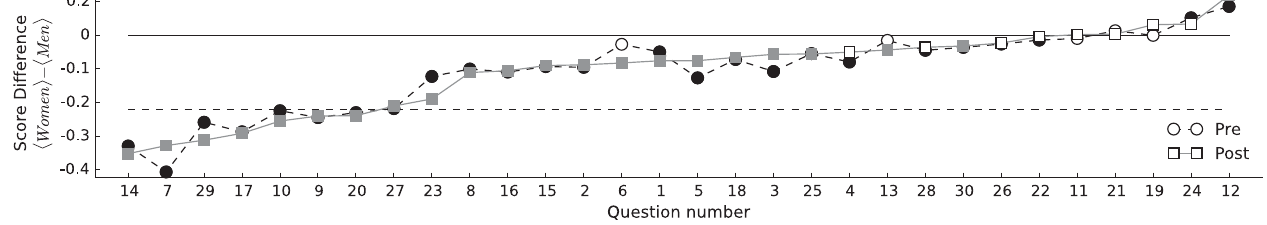
FIG. 2. Sorted plot of the difference between the average scores (points) of women and men on each item of the E-CLASS. Zero difference is marked by the solid horizontal line, and statistically significant differences are denoted by solid markers. The dotted horizontal line marks the point below which the differences between men ’ s and women ’ s scores represent moderate effect sizes ( d > 0 . 3 ). See Ref. [9] for the full list of question prompts.